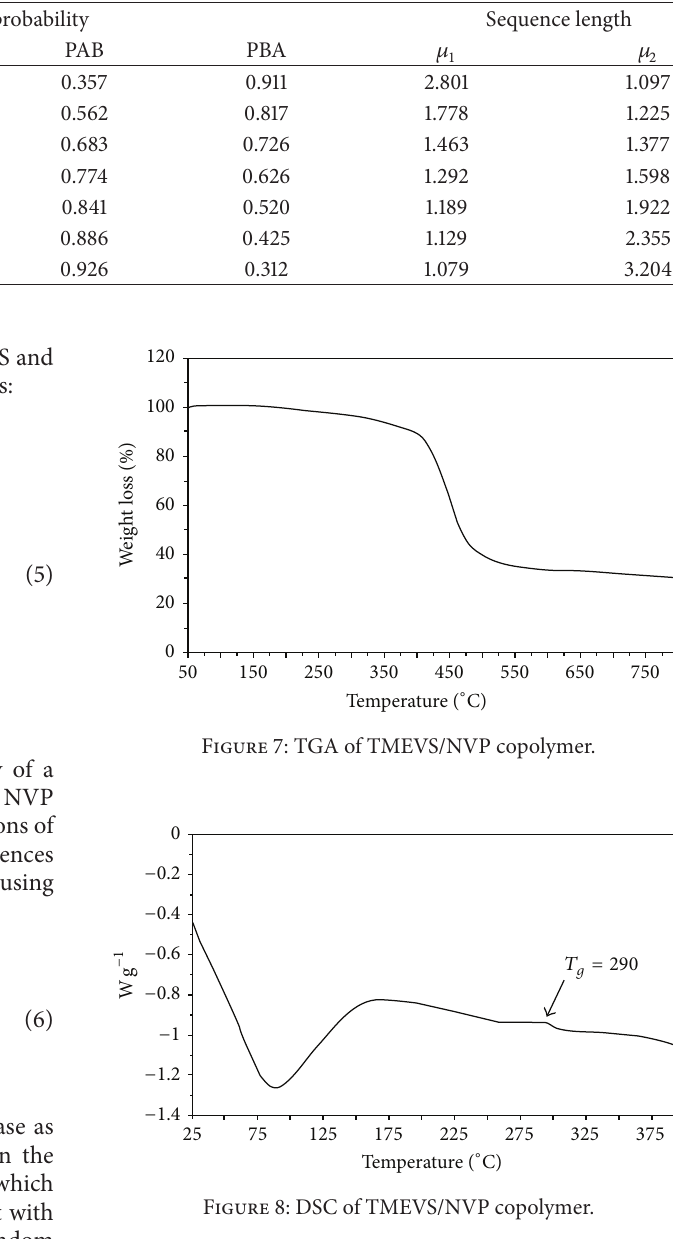
Table 6: Statistical data of TMEVS/NVP copolymer.